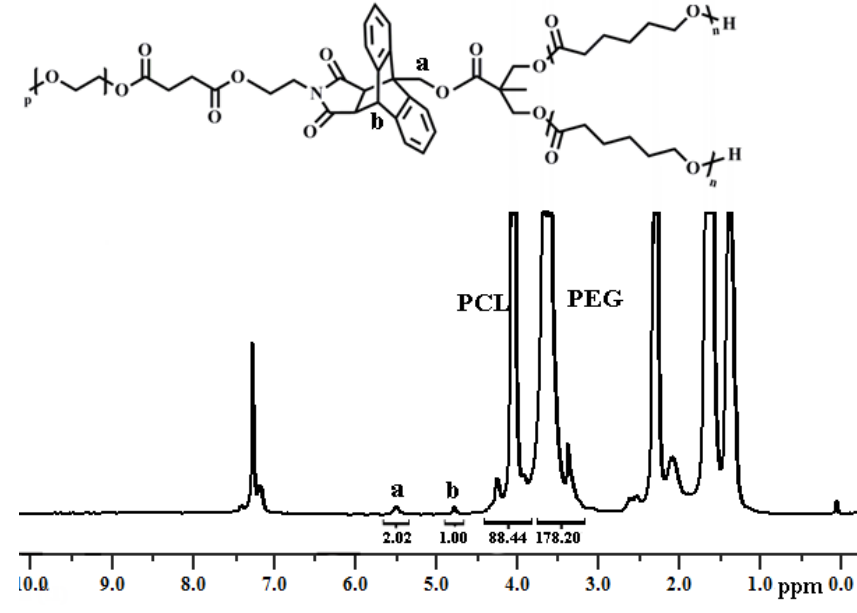
and the resulting Y-shaped 2